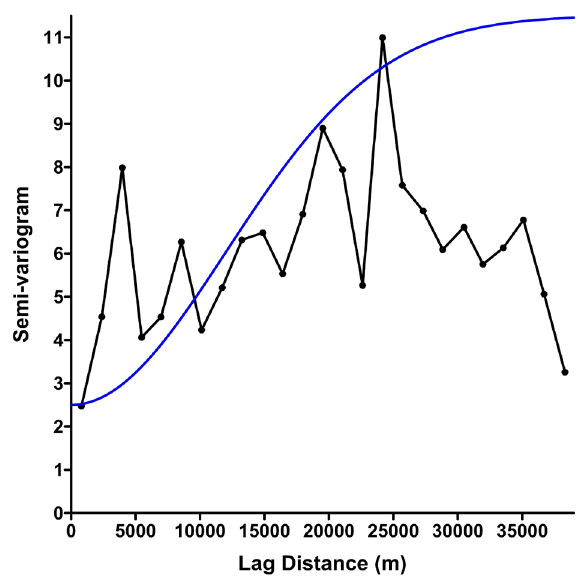
Figure 6. Omni-directional semi - variogram shows adjustment of the theoretical model to the experimental curve. Blue line is the mathematical semi-variogram model; the estimated semi-variogram is represented by the black line.